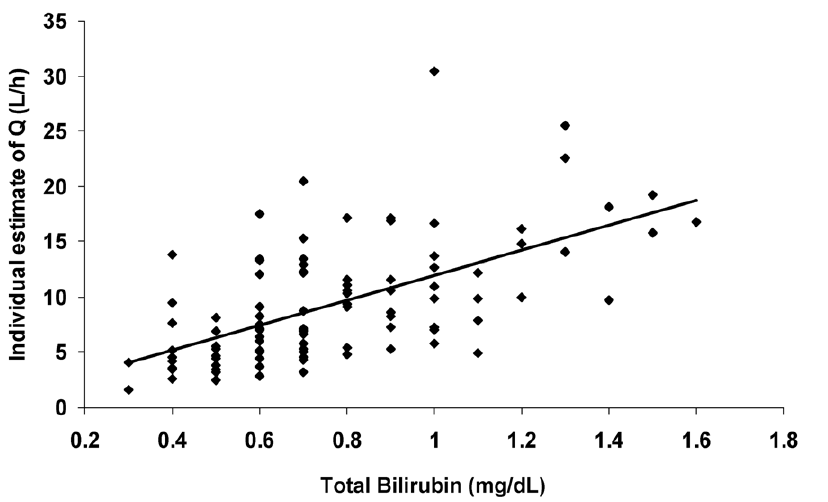
Figure 1. Individual estimate of Q vs. baseline total bilirubin (with full phase I dataset). Regression analysis; Q=11.21 * Bilirubin level + 0.7422 (P ,